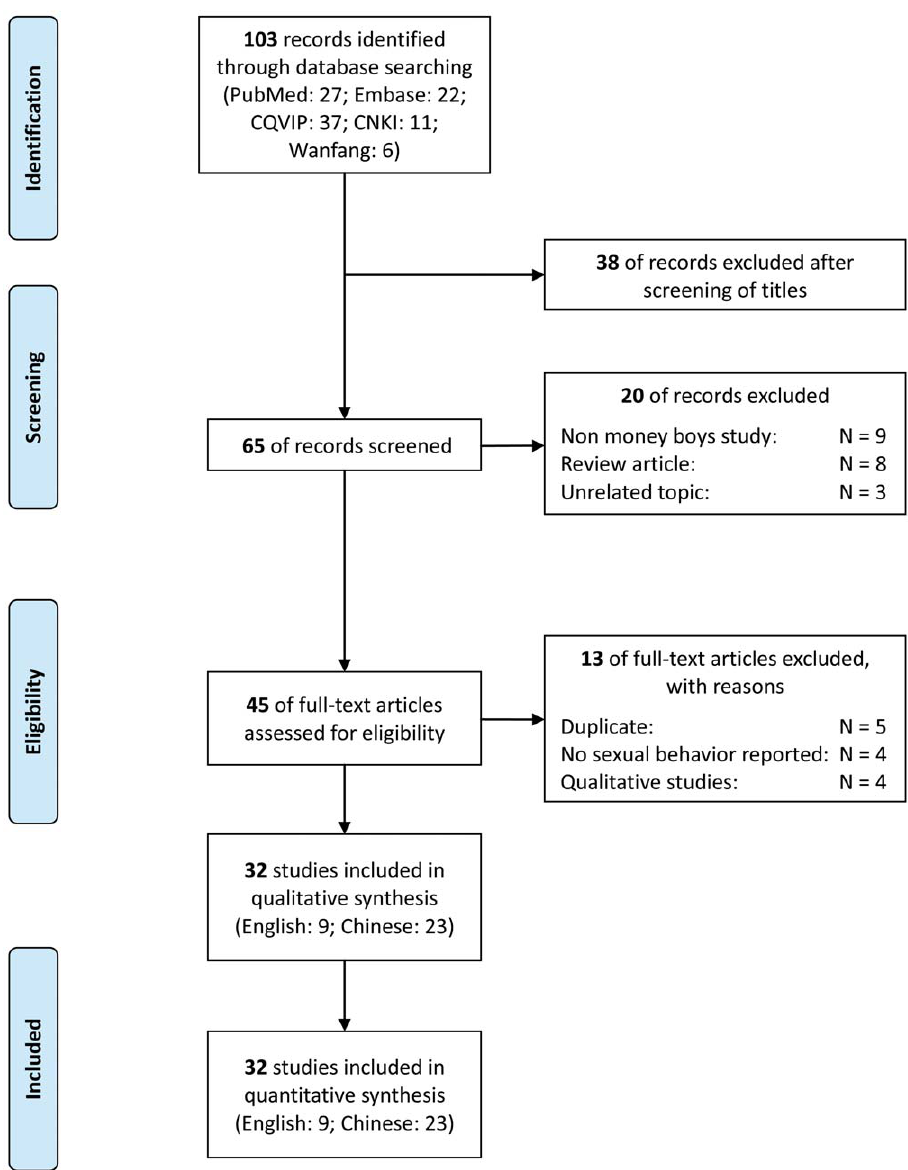
Figure 1. PRISMA flow chart for selection of studies with number of articles (N).